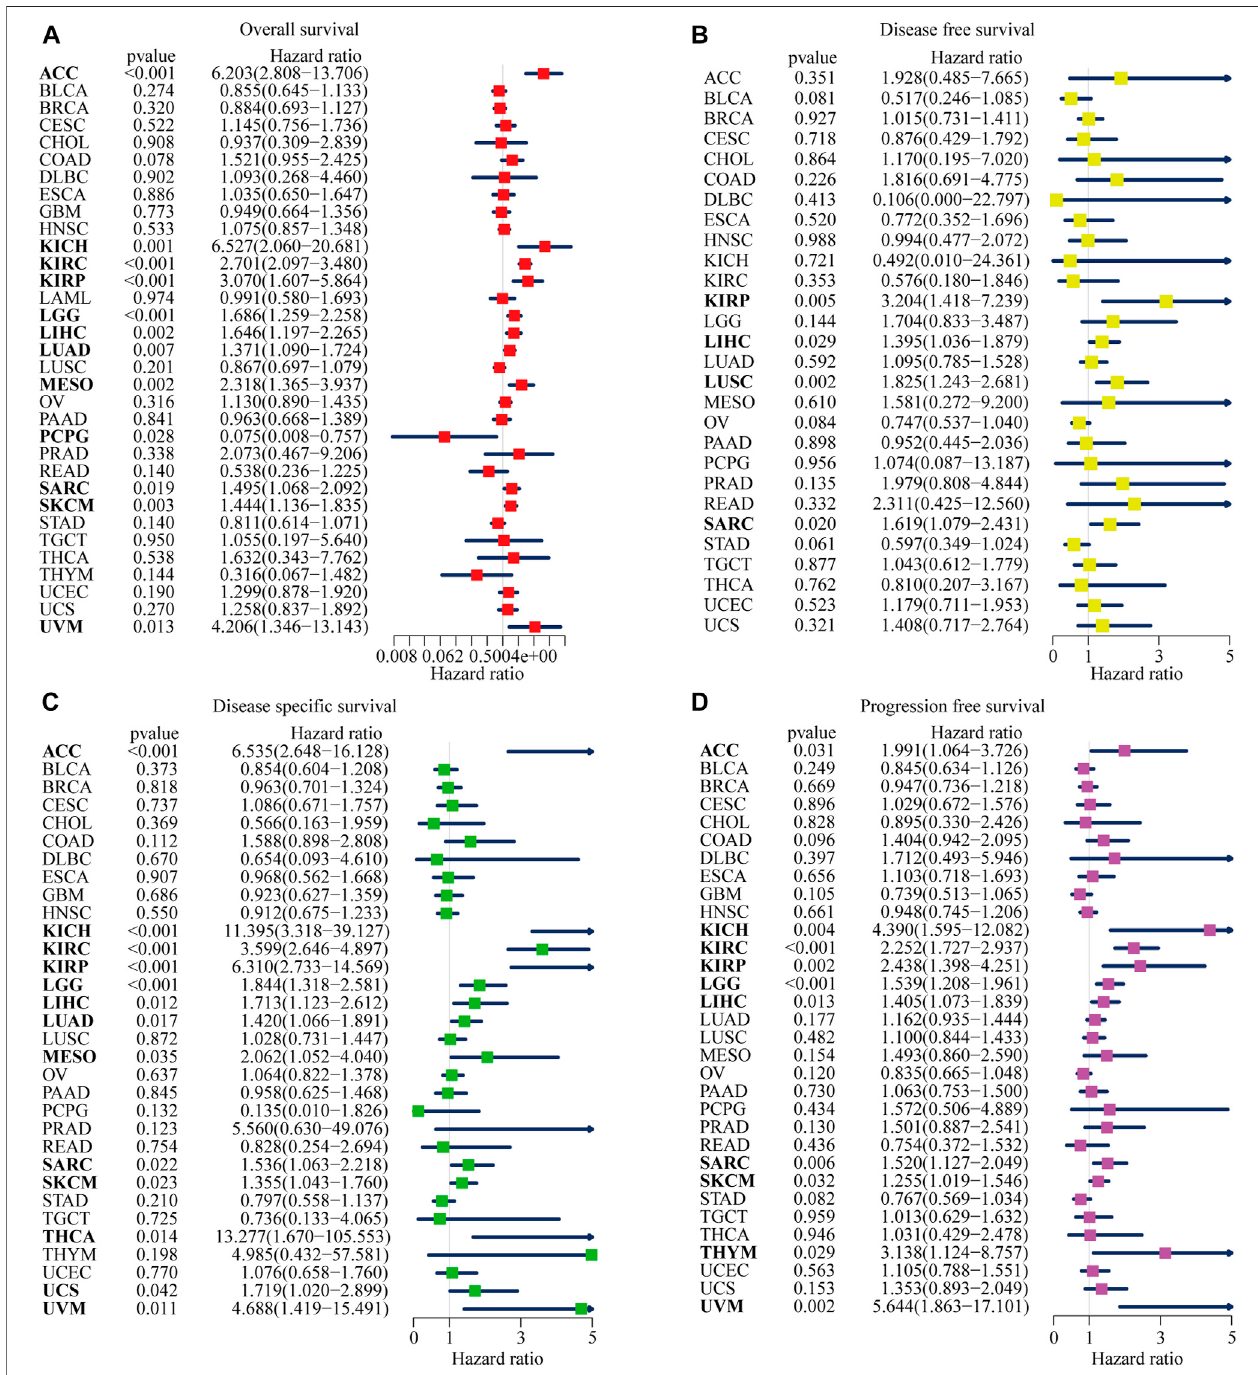
FIGURE 3 | Forest plots of NOP2 expression on the prognosis of various cancers using univariate Cox regression analyses. The bold items mean that NOP2 expressionwassigni fi cantlycorrelatedwithprognosisinthesetypesofcancers( p < 0.05). (A) EffectofNOP2onOSin33typesofcancers. (B) EffectofNOP2onDFSin 33 types of cancers. (C) Effect of NOP2 on DSS in 33 types of cancers. (D) Effect of NOP2 on PFS in 33 types of cancers.